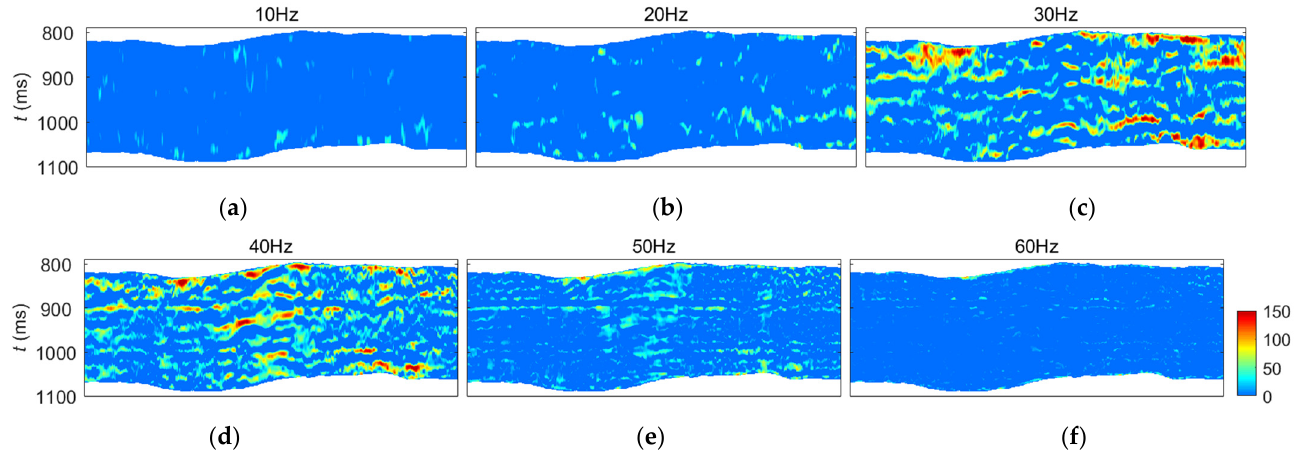
Figure 13. Spectral decompositions of the seismic profile in Figure 11, calculated using ISD at frequencies of ( a ) 10 Hz, ( b ) 20 Hz, ( c ) 30 Hz, ( d ) 40 Hz, ( e ) 50 Hz, and ( f ) 60 Hz.